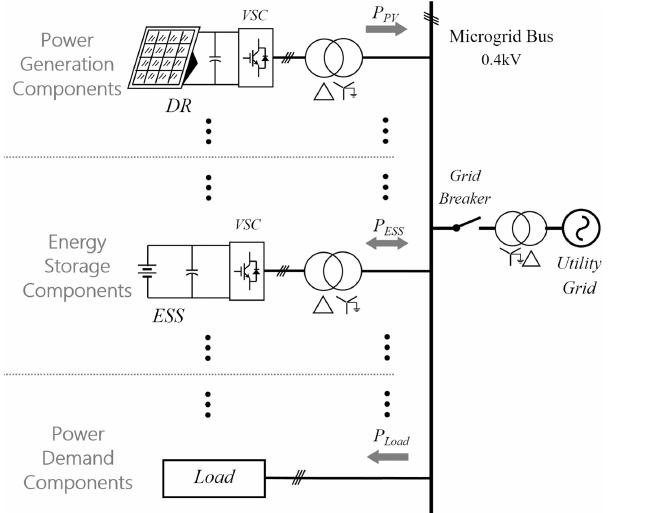
Figure 1. Scheme of a typical